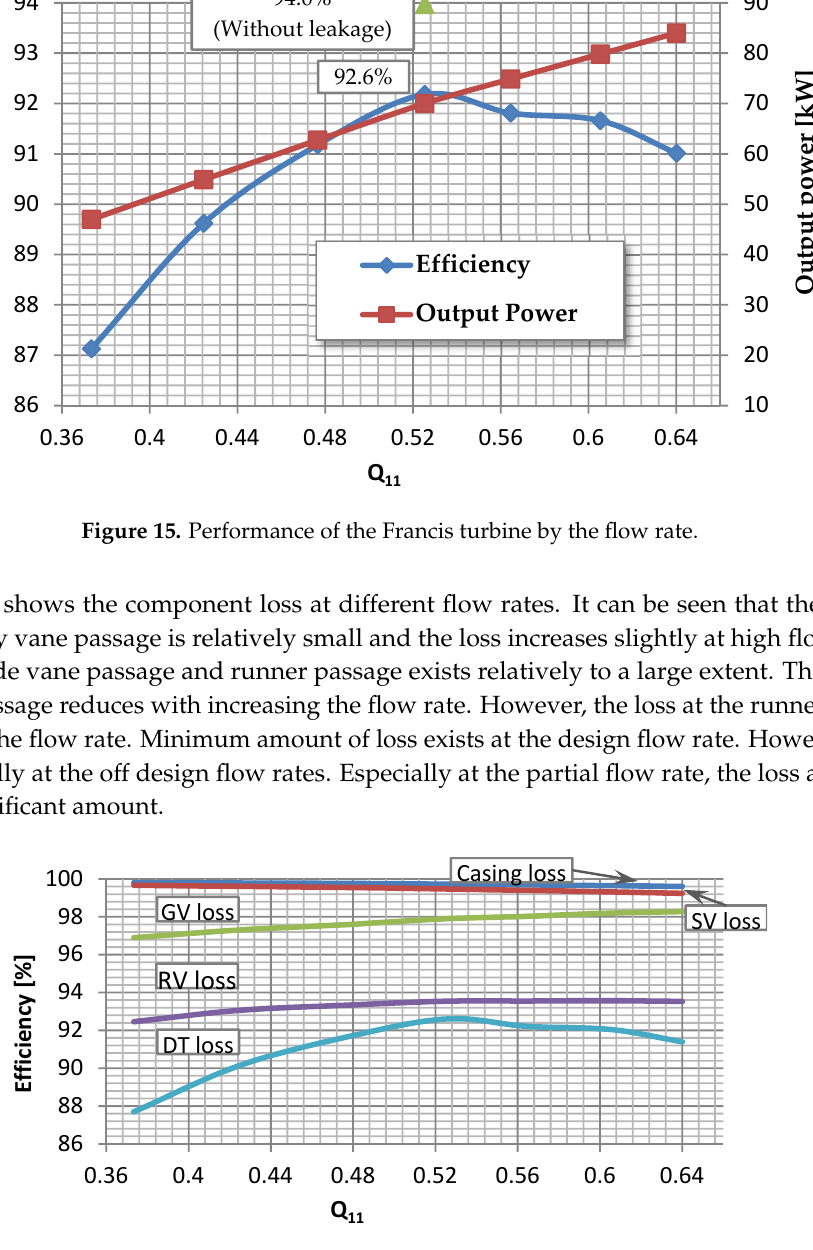
Figure 16. Component loss by the flow rate.